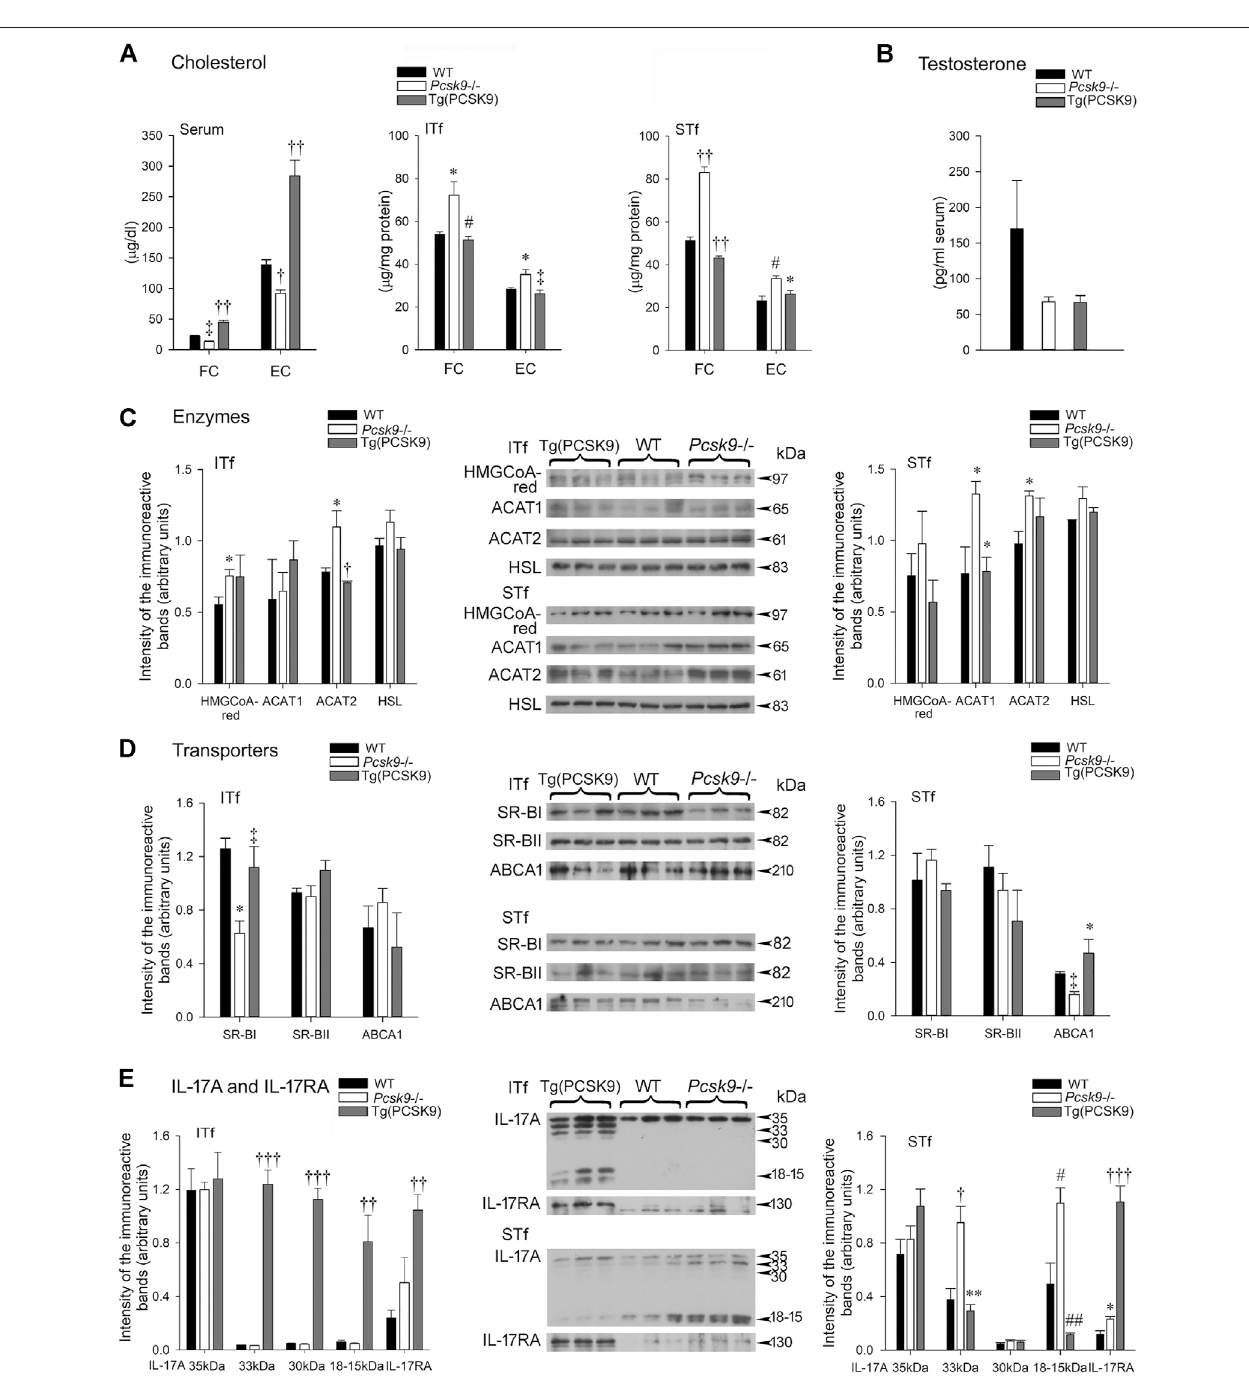
FIGURE 3 | (A) Cholesterol (B) Serum testosterone (C) Cholesterol enzymes (D) Cholesterol transporters and (E) IL-17A and IL-17RA (A) Serum free cholesterol (FC) levels are signi fi cantly ( ‡ p < 0.03) lowered in Pcsk9 − / − compared to the WT counterparts. The increase in Tg (PCSK9) mice is signi fi cant ( †† p < 0.001) compared to theWT counterparts and Pcsk9 − / − mice.Thedropinesteri fi edcholesterol (EC)in Pcsk9 − / − issigni fi cant( † p < 0.01) compared toWTandits increase inTg(PCSK9)mice issigni fi cant( †† p < 0.001)incomparisontotheWTand Pcsk9 − / − mice.InITf,FCincreasesin Pcsk9 − / − (* p < 0.05vs.WTmice)butrecoversinTg(PCSK9)mice( # p < 0.02 vs. Pcsk9 − / − ). EC values signi fi cantly increase in Pcsk9 − / − mice (* p < 0.05 vs. WT) but decrease in Tg (PCSK9) mice ( ‡ p < 0.03 vs. Pcsk9 − / − ). In STf, the increase in FC in Pcsk9 − / − mice ( †† p < 0.001 vs. WT mice) and the decrease in Tg (PCSK9) mice are signi fi cant ( †† p < 0.001 vs. Pcsk9 − / − mice). EC levels signi fi cantly augmented in Pcsk9 − / − mice( # p < 0.02vs.WTmice)butdecreasedinTg(PCSK9)mice(* p < 0.05vs. Pcsk9 − / − mice). (B) Thedifferencesintestosteronelevelsarenotsigni fi cantinthe WT, Pcsk9 − / − andTg(PCSK9)mice. (C) Cholesterolenzymes:InITf,HMGCoA-redlevelsincreasesin Pcsk9 − / − (* p < 0.05vs.WTcounterparts).ACAT2levelsincreasein Pcsk9 − / − (* p < 0.05 vs. WT mice) but drop in Tg (PCSK9) mice ( † p < 0.01 vs. Pcsk9 − / − mice). In STf, ACAT1 levels signi fi cantly rise in Pcsk9 − / − mice (* p < 0.05 vs.